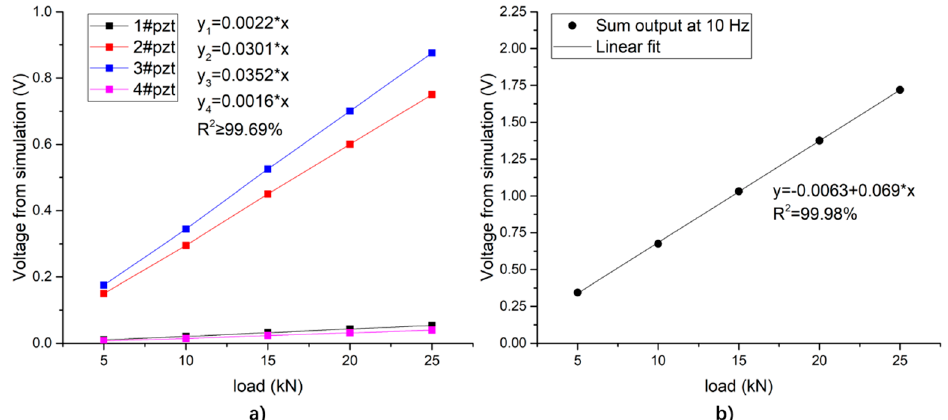
Figure 19. Relationship between the peak-to-valley value of the output voltage and the peak value of the load under sinusoidal loading simulation. ( a ) The output of each piezoelectric unit; ( b ) the total output of the piezoelectric sensing system.